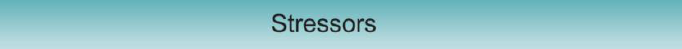
FIGURE 1: Schematic illustration of nu- cleolar stress. Various stressors induce nucleolar stress, accompanied by mor- phological changes and functional de- fects, ultimately resulting in activation of p53 signaling pathway and altered cell